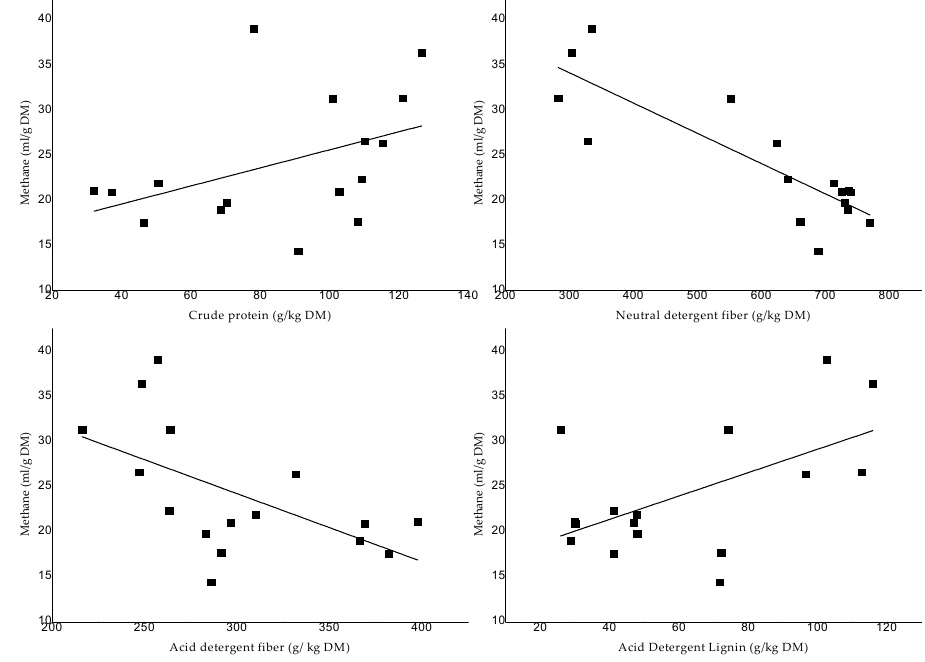
Figure 2. Relation between chemical composition and methane